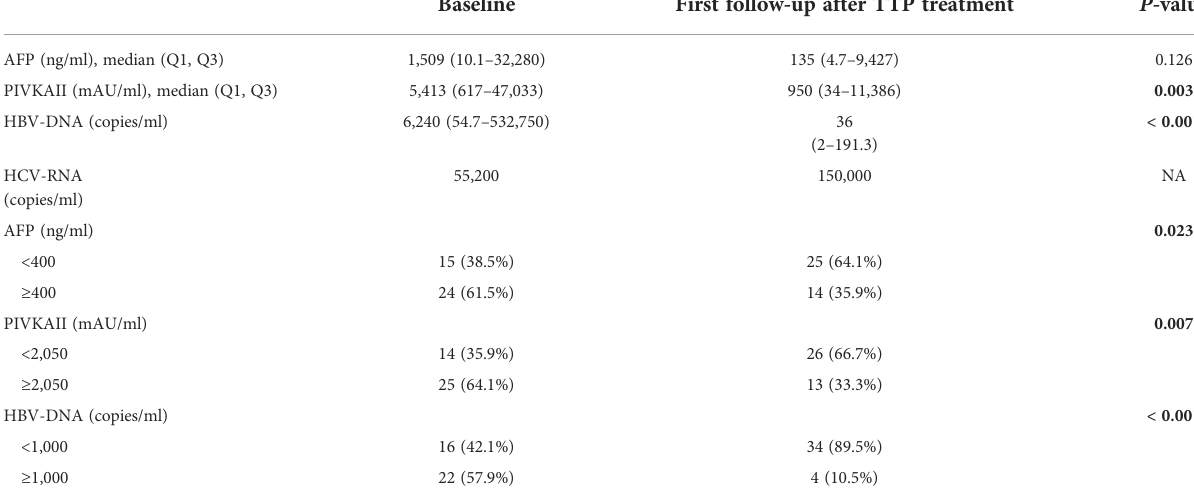
TABLE 4 Change of tumor marker expression. Baseline First follow-up after TTP treatment P- value